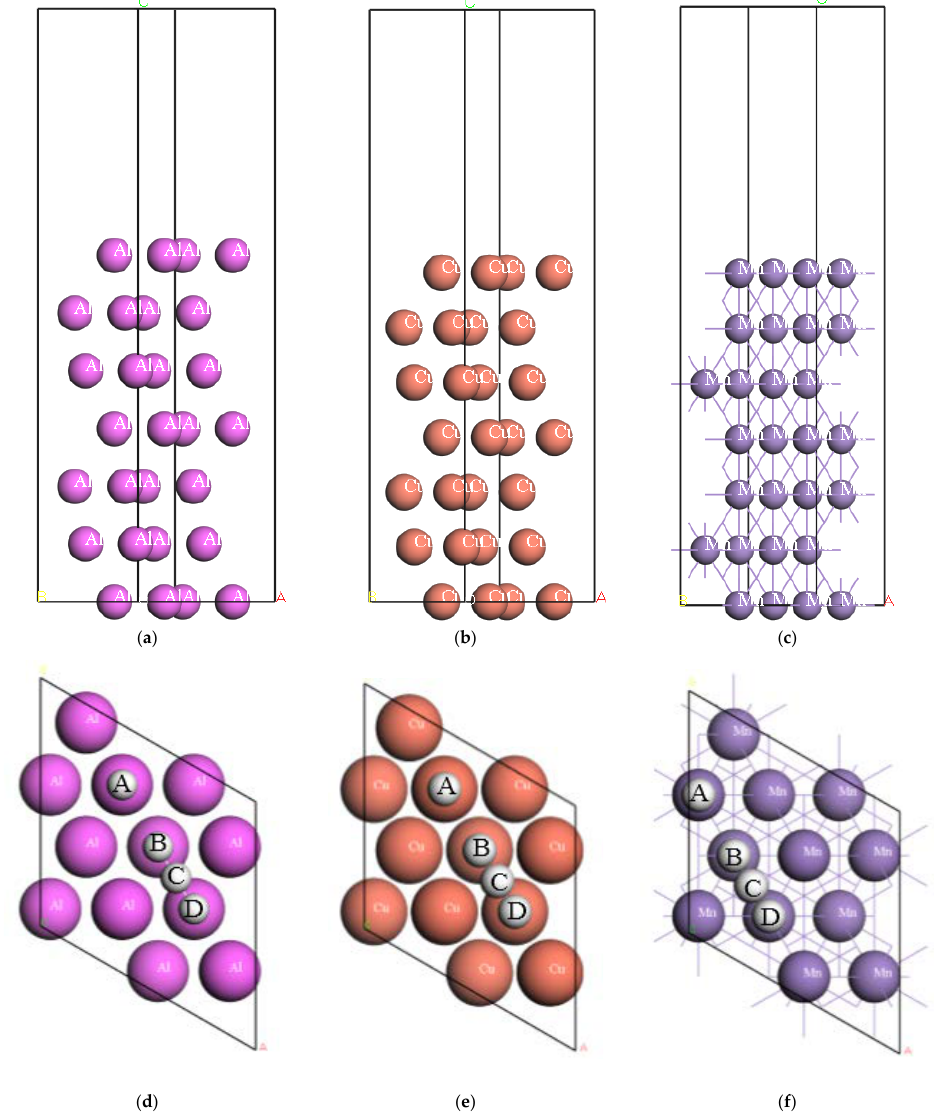
Figure 1. Schematic illustration of the side structure of surface model of ( a ) Al(111), ( b ) Cu(111) and ( c ) Mn(111), along with the adsorption sites of H on ( d ) Al(111), ( e ) Cu(111) and ( f ) Mn(111).